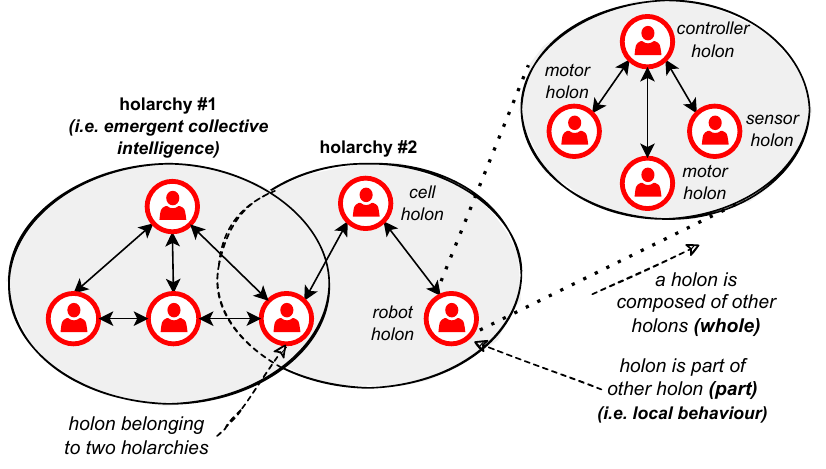
Figure 2. Features of holonic